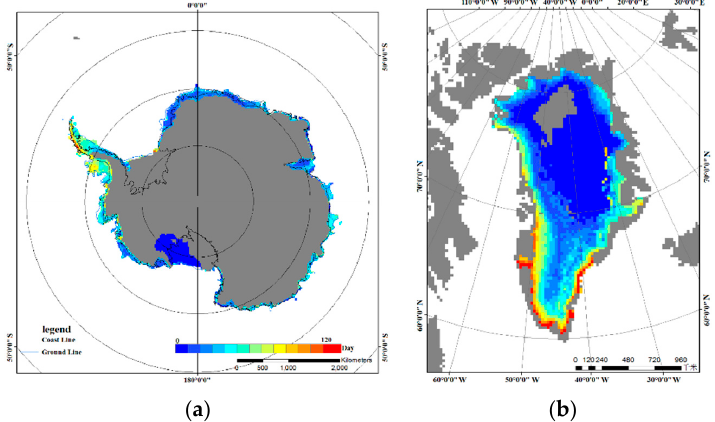
Figure 4. Average annual melt duration from 1978 to 2014 in ( a ) Antarctican and (b) Greenland ice sheets.